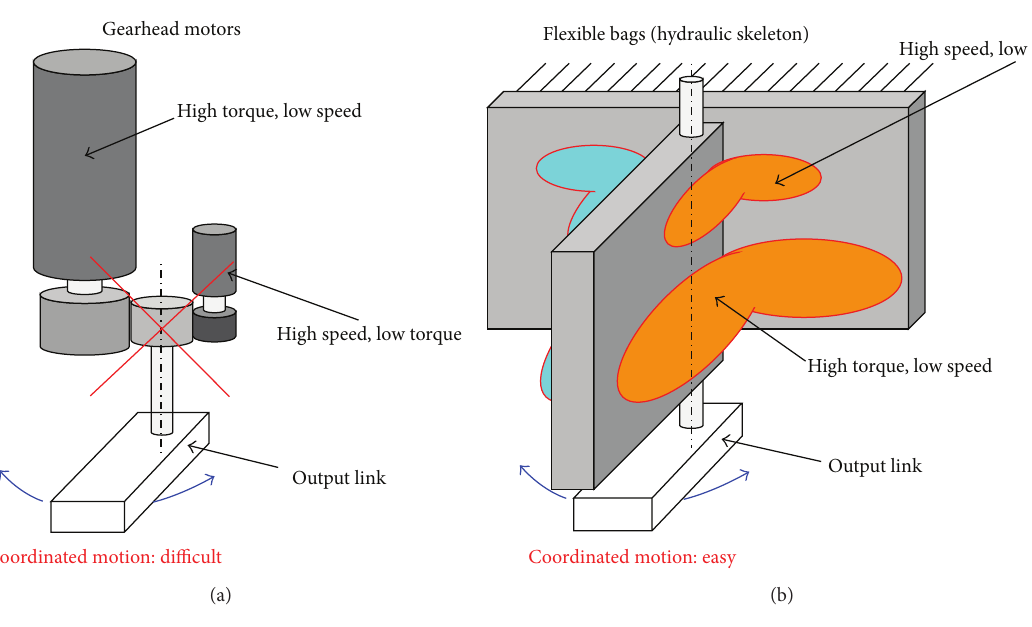
Figure 2: Comparison between conventional and proposed